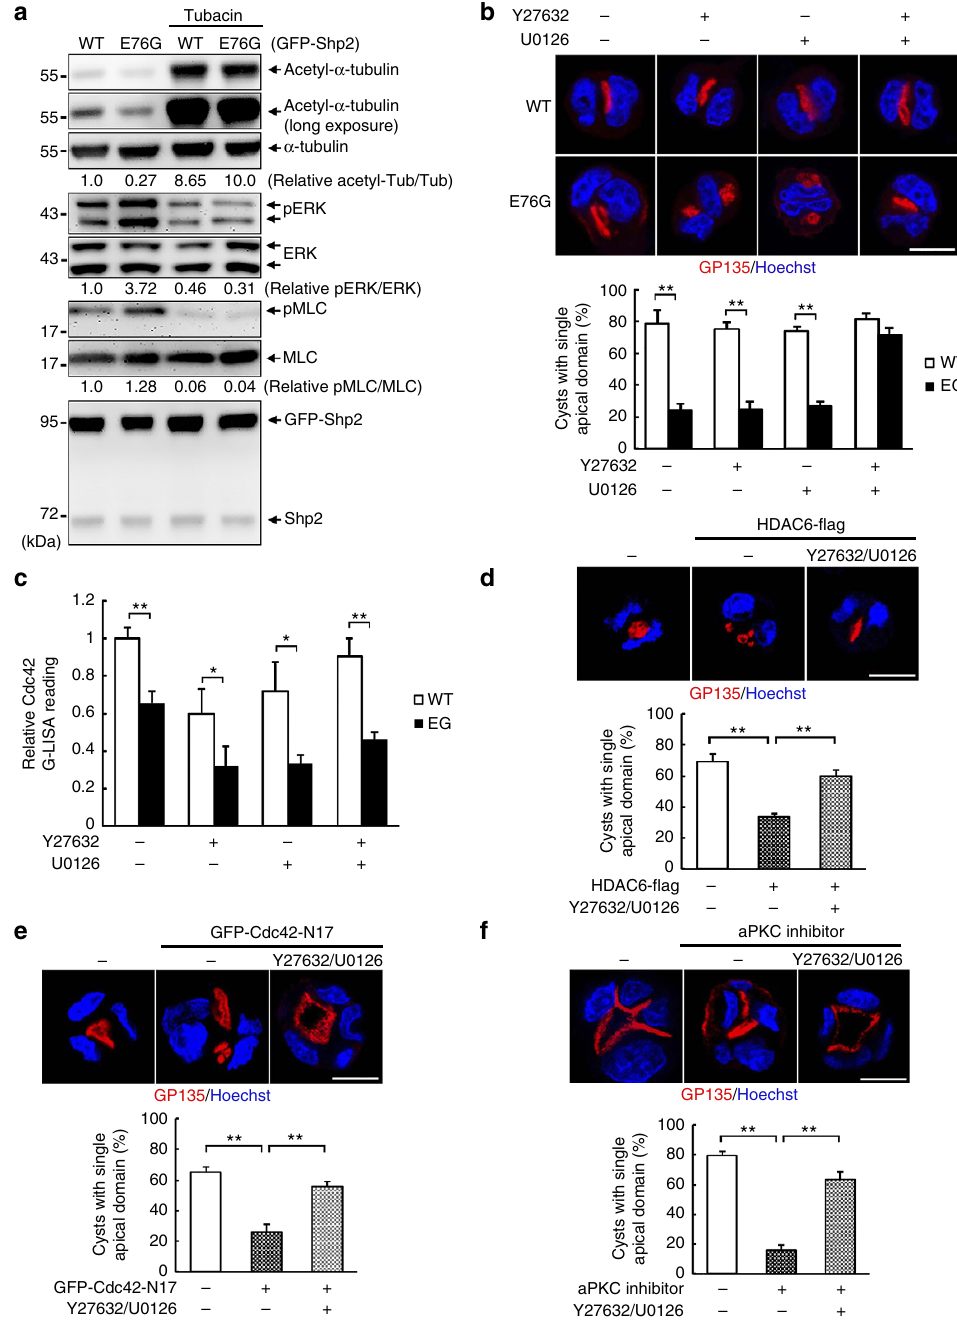
Figure 6 | The involvement of ERK/Myosin II in restoring normal lumenogenesis by HDAC6 inhibition. Shp2-WT and E76G cells were embedded in Matrigel for 2 days. ( a ) Western blot analysis of 2-day cysts that had been daily treated with tubacin (1 m M). ( b ) Cyst cultures were treated with Y27632 (10 m M), U0126 (10 m M) or their combination for 2days. Cysts were extracted for IF staining with antibodies as indicated, scale bar, 10 m m. The percentage of cysts with single apical domain is shown below (323–381 cysts were counted in each experiment, n ¼ 3). Data are presented as mean ± s.d. from three independent experiments; two-tailed unpaired Student’s t -test. ** P o 0.01. ( c ) The cysts were harvested for Cdc42 activity by G-LISA assay. ( d ) Control MDCK cells were transfected with the vector GFP-C1 in the presence of control vector or HDAC6-Flag as indicated (amount of DNA ratio at 1:3). These cells were embedded in Matrigel and treated with Y27632/U0126. Cysts were extracted and fixed for IF staining with GP135. Percentage of cysts with single apical domain (158–163 green-positive cysts were counted in each experiment, n ¼ 3) is shown below and analysed by two-tailed unpaired Student’s t -test. ** P o 0.01. ( e ) Control MDCK cells transfected with the vector GFP-C1 or GFP-Cdc42-N17 were embedded in Matrigel and treated without and with Y27632/ U0126. Cysts were extracted and stained with GP135 (red) and Hoechst (blue). The bottom panel shows the percentage of cysts with single apical domain (104–117 green positive were counted in each experiment, n ¼ 3). Statistical significance was analysed by two-tailed unpaired Student’s t -test. ** P o 0.01. ( f ) Control MDCK cells were treated with of aPKC inhibitor (20 m M) without and with Y27632/U0126. The percentage of cysts with single apical domain is shown below (346–393 cysts were counted in each experiment, n ¼ 3). Values are mean ± s.d. from three independent experiments. ** P o 0.01 based on two-tailed unpaired Student’s t